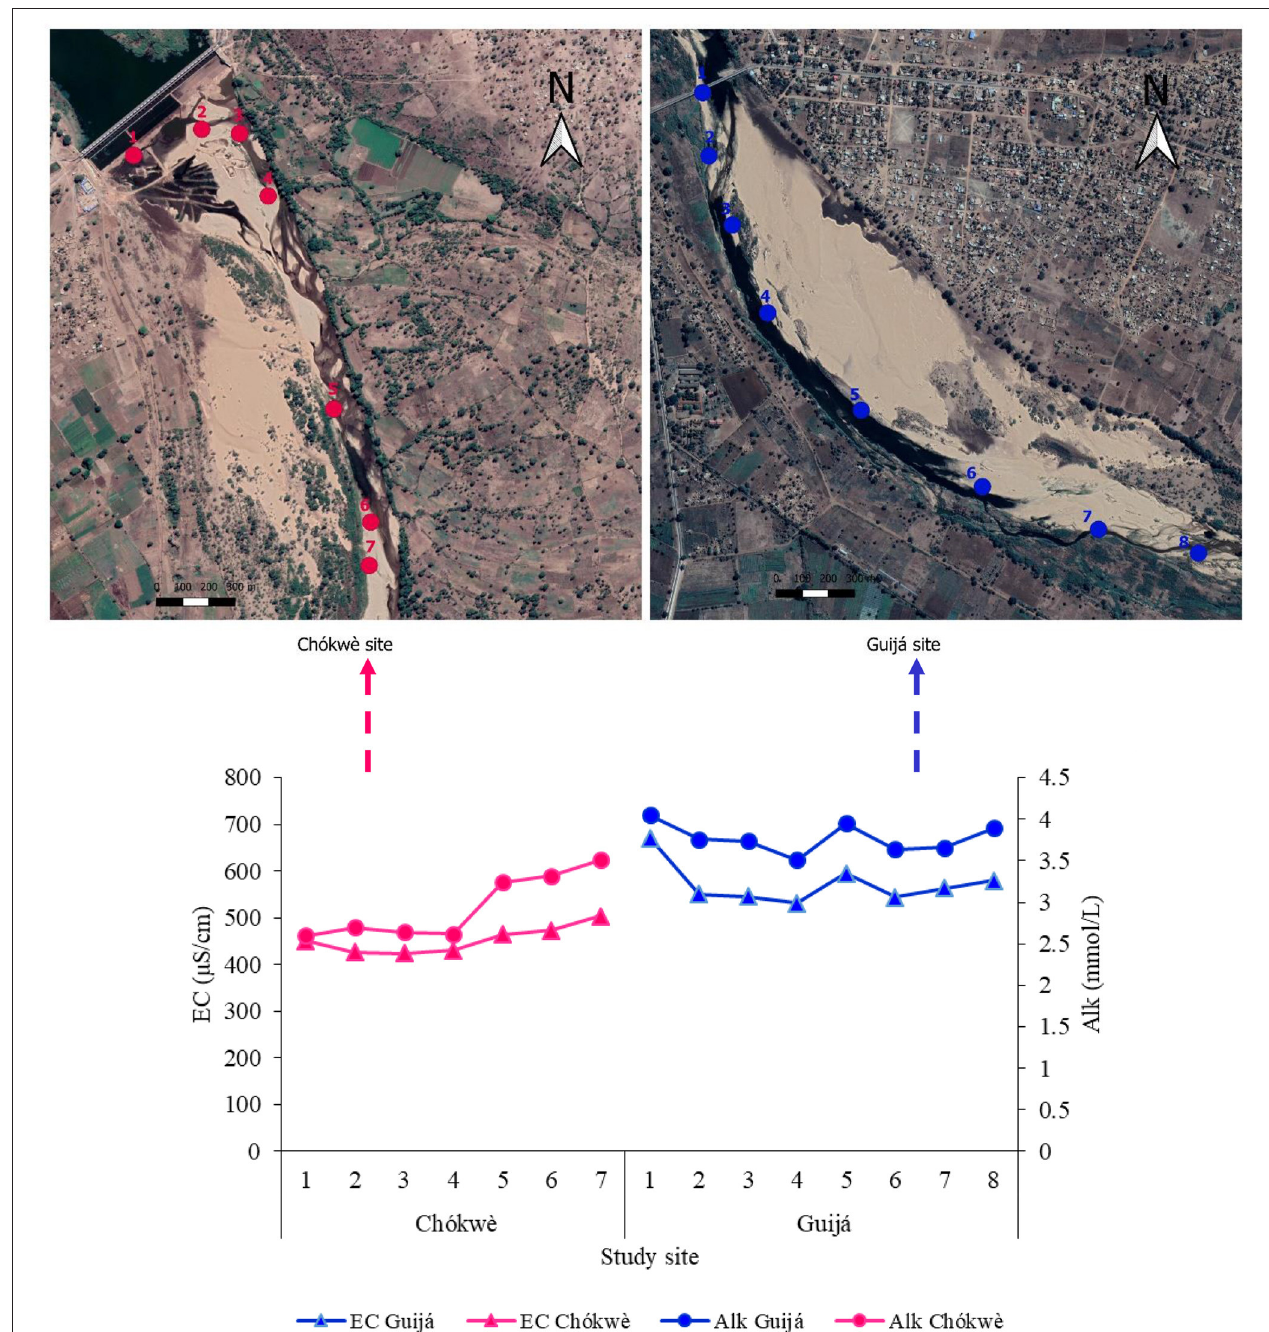
FIGURE 10 | Variation of electrical conductivity and alkalinity from Chókwè to Guijá site in the river and the respective location in the base map from satellite imagery Google Earth pro.